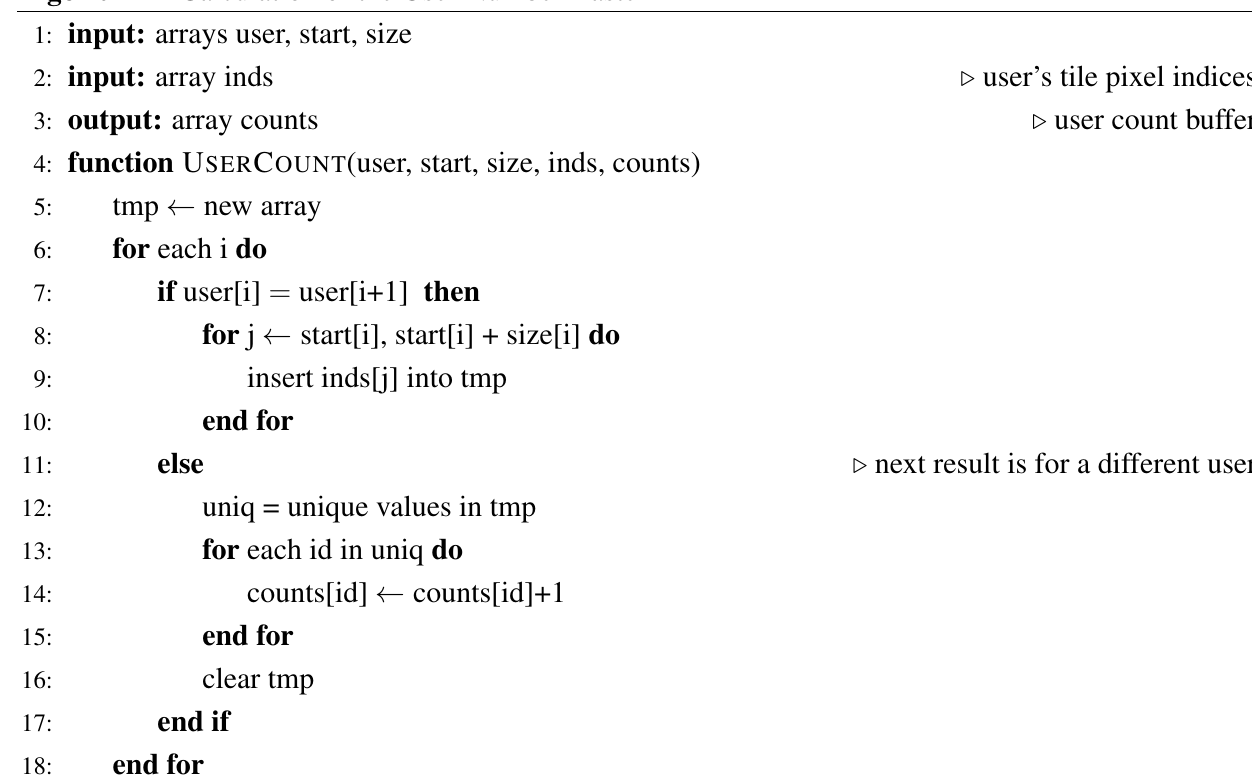
Algorithm 1 Calculation of the User Number